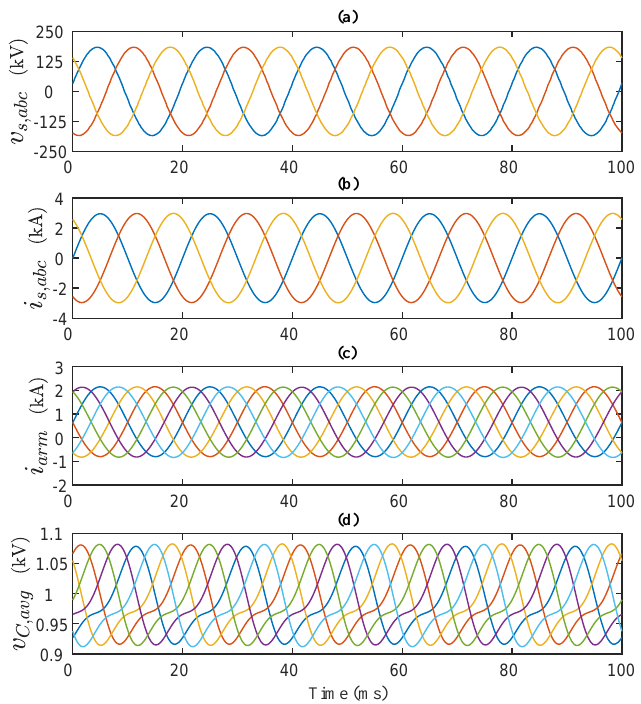
Figure 17. Steady–state waveforms of voltage and current in the MMC–HVDC system: ( a ) voltages in the output terminal ( v s , abc ), ( b ) currents in the output terminal ( i s , abc ), ( c ) arm currents of the MMC